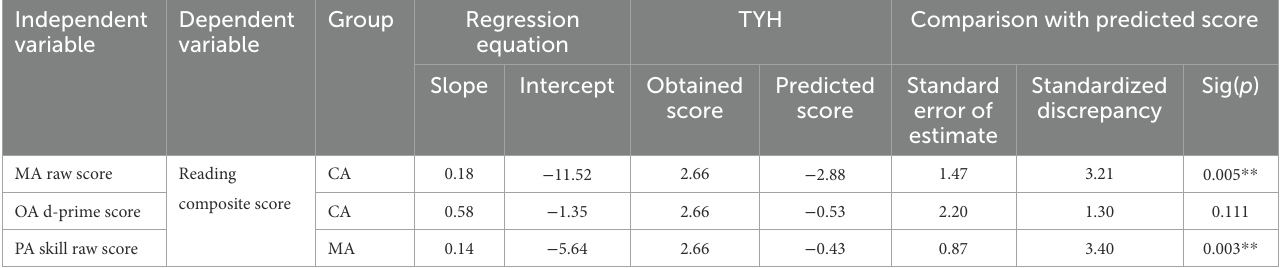
TABLE 6 The comparison of obtained reading composite score in TYH and the predicted score by meta-linguistic awareness skills based on the equation built on data from the CA and MA groups. Independent